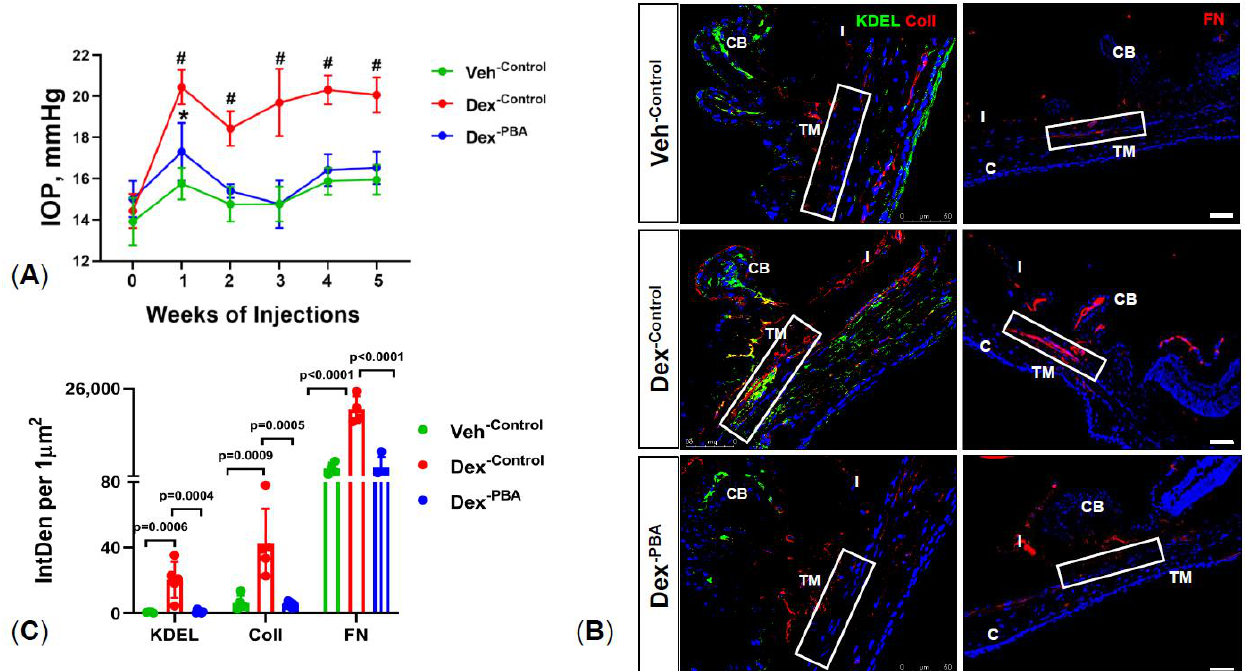
Figure 1. PBA prevents Dex-induced IOP elevation and abnormal ECM deposition in mouse TM: Three-month old C57BL/6J mice were injected bilaterally once a week for 5 weeks with either Veh or Dex and applied 6 µL of topical ocular eye drops of either water (control) or PBA (1%) twice a day throughout the study period. ( A ) Dex-injected mice receiving control eye drops (Dex -Control ) showed significant IOP elevation compared to Veh-injected mice receiving control eye drops (Veh -Control ). Topical ocular eye drops of PBA (1%) significantly lowered IOP in Dex-injected mice (Dex -PBA ) compared to Dex -Control mice. Data are shown as mean ± SD ( n = 8 to 10 eyes; 2–WAY ANOVA with multiple comparison; * indicates p = 0.02; # indicates p < 0.0001). ( B ) Immunohistochemical images showing expression of KDEL and ColI (left panel) and FN (right panel) in mouse TM tissues (highlighted by a rectangle white box) (Scale bar is 50µm). ( C ). Densitometric analysis showing increased expression of ER stress (KDEL) and ECM proteins (ColI and FN) in TM tissues of Dex -Control mice. Additionally, 1% PBA topical ocular eyedrops significantly reduced ER stress and ECM markers in the TM tissues of Dex -PBA mice group. Data are shown as mean ± SD ( n = 4, ONE WAY ANOVA with multiple comparison). CB: ciliary body; I: iris; C: cornea.